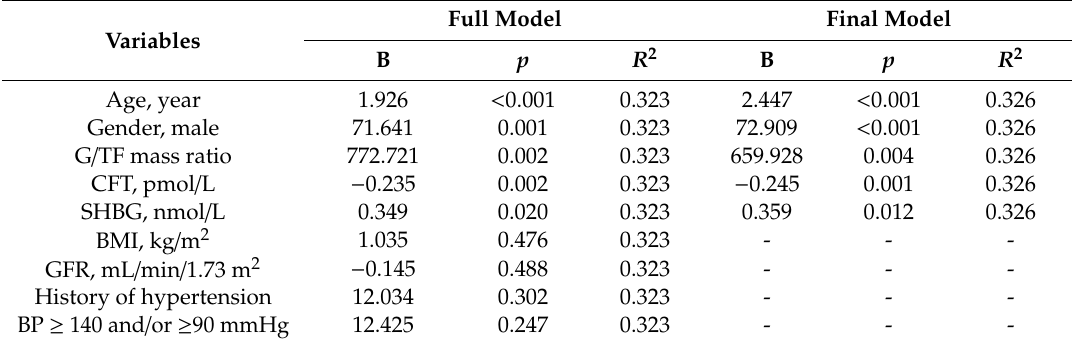
Table 4. Results of stepwise backward linear regression analysis of relative NT-proBNP concentration with baseline